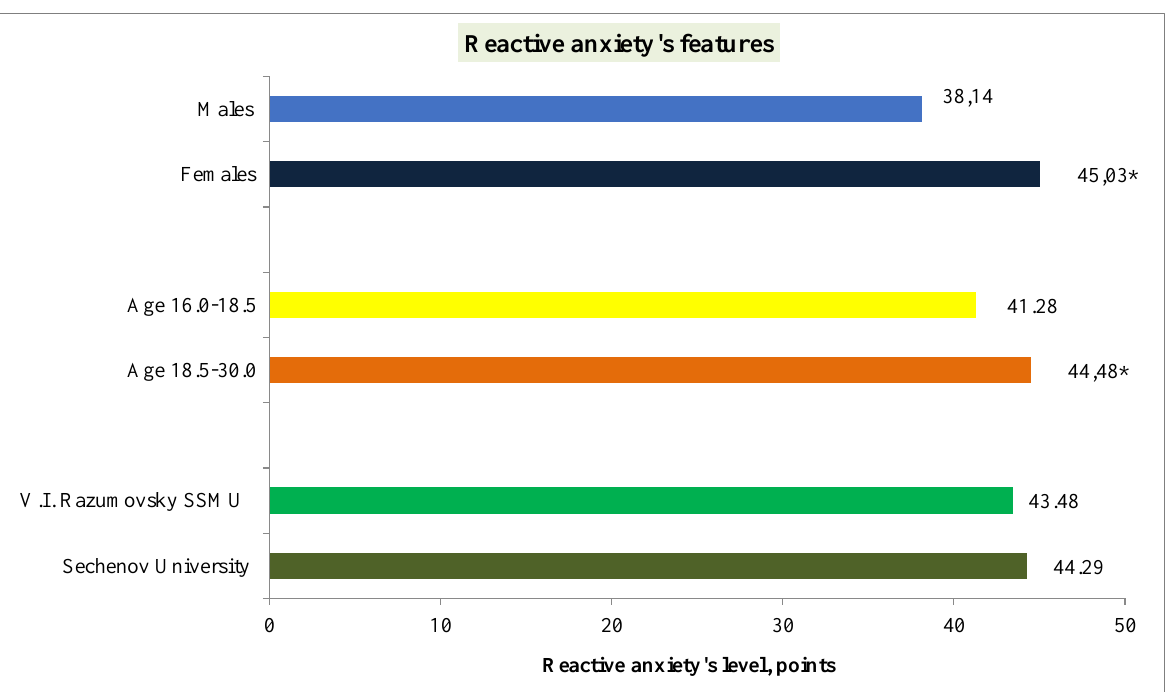
Figure 1. Distribution of V.I. Razumovsky SSMU students depending on the reactive anxiety's level. Note: * Significant differences in comparison with the percentage of students with low anxiety, p <0.05. It was found that the reactive anxiety indicator depended on gender and age (Figure 2).